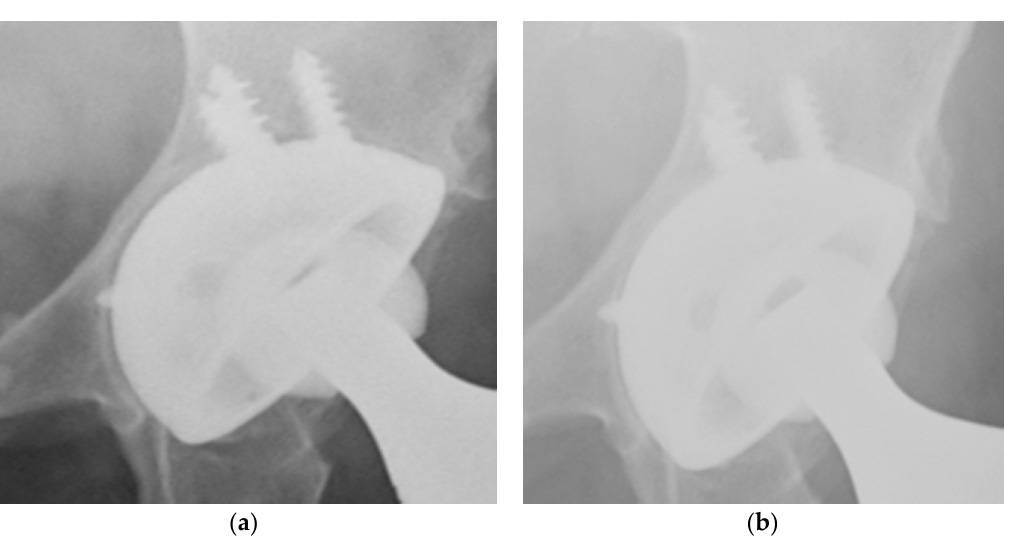
Mild heterotopic ossification (type 1–2 according to the Brooker classification) was found